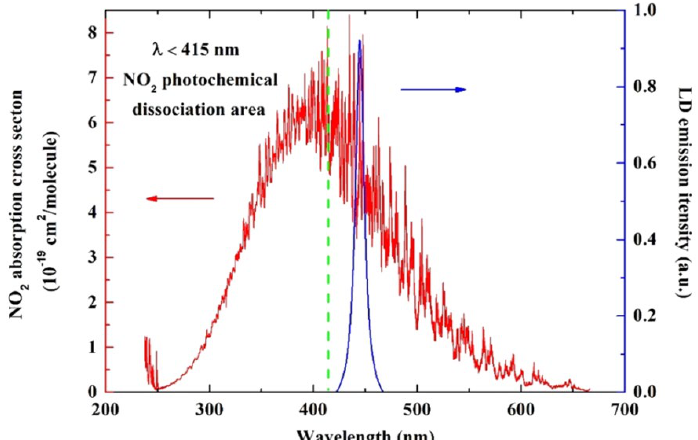
Figure 1. NO 2 absorption cross section (red) including the photochemical dissociation area (green) and emission spectrum (blue). Reprinted from Li et al., Photoacoustics, 2022, 100325 [21], with permission of Elsevier.